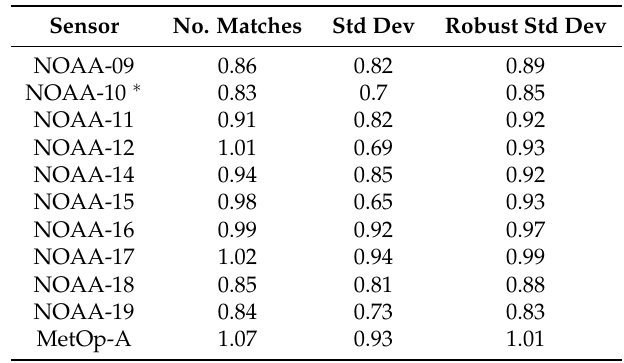
Table 8. Ratio of two-channel (10.8 and 12 µ m) daytime SST retrieval statistics using Bayesian and CLAVR-x cloud masks compared against GTMBA data. Ratios are calculated using satellite minus in situ SST differences, first applying the Bayesian mask and then comparing against the same statistics with the CLAVR-x mask applied. Values less than one in each column indicate that the Bayesian mask has fewer matches, lower standard deviation or lower robust standard deviation.